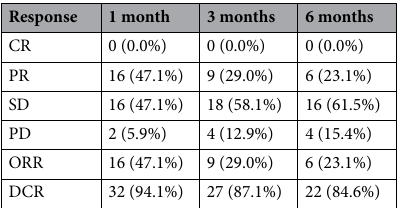
Table 3. Local tumor response. CR, complete response; DCR, disease control rate; ORR, objective response rate; PR, partial response; SD, stable disease; PD, progressive disease.